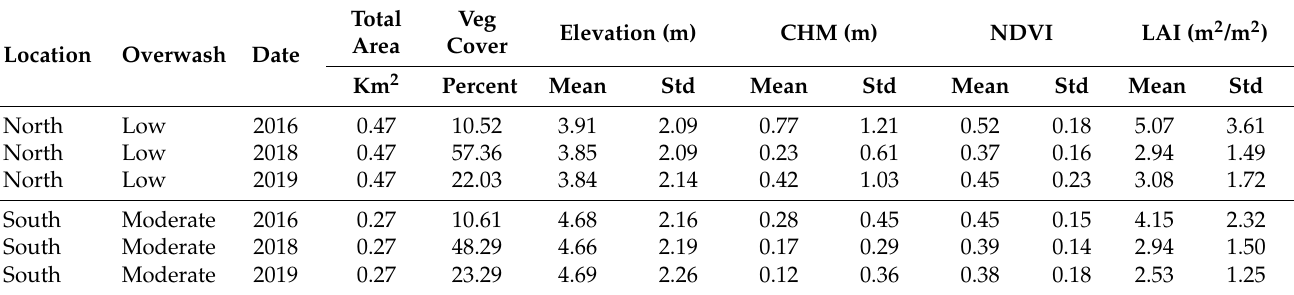
Table 5. Raster-derived mean area (Total Area), vegetation cover (Veg Cover), elevation, canopy height (CHM), normalized difference vegetation index (NDVI), and leaf area index (LAI) within the Pea Island assessment